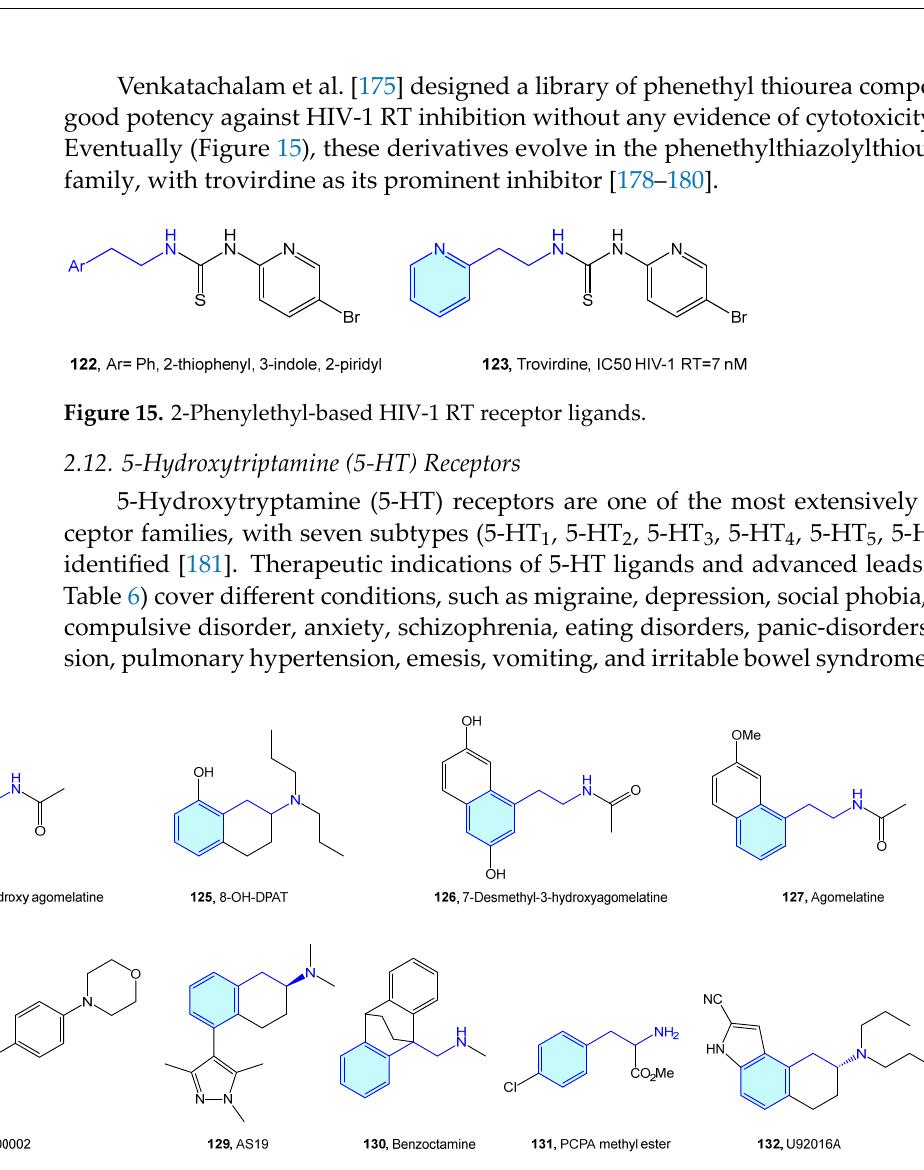
Figure 16. 2-Phenylethyl-based 5-HT medicinal chemistry leads. Table 6. 5-HT medicinal chemistry leads.